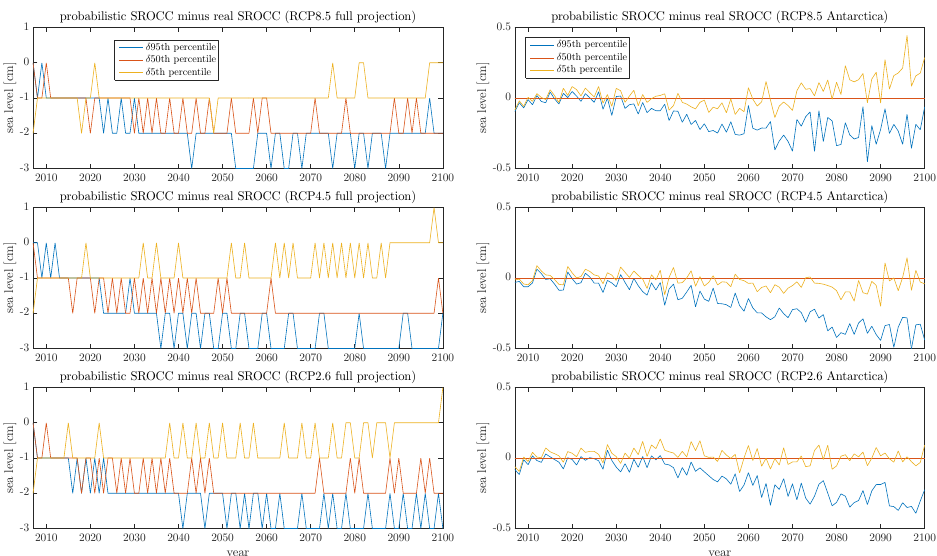
Figure 1. The difference between the real SROCC projections and our probabilistic emulation at the published percentiles as a function of time. The left panels show the full projection and the right panels show the Antarctic contribution. The top panels show RCP8.5, the middle panels RCP4.5 and the lower panels